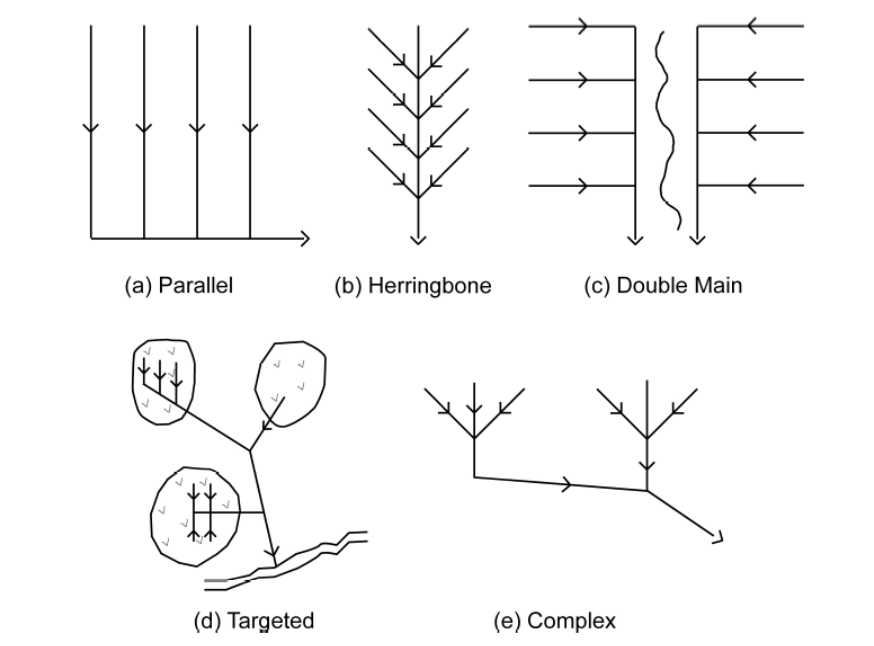
Figure 1. Commonly used subsurface drainage system patterns (modified from